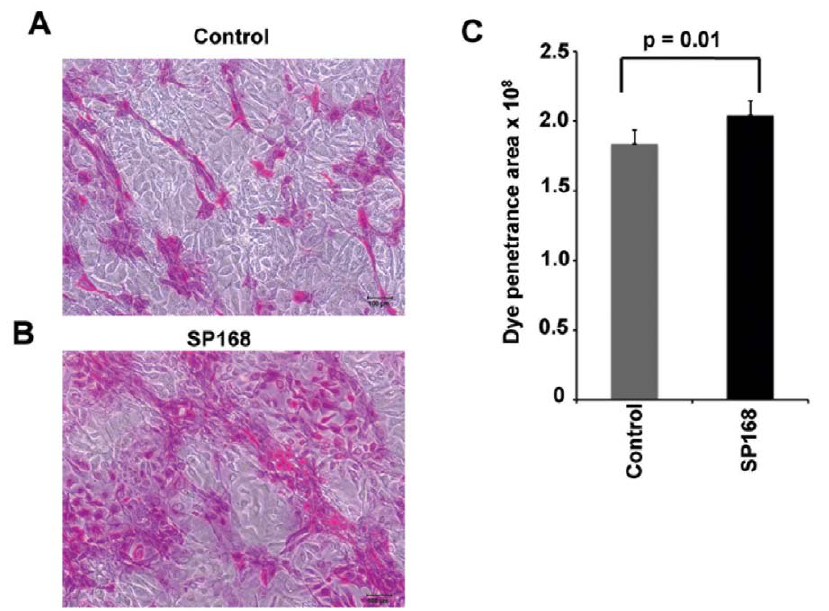
Figure 7. Rose bengal penetrance into HCLE cells increases after SP168 growth culture filtrate treatment. Brightfield micrographs were taken of HCLE cells stained with rose bengal dye following exposure to ( A ) medium only control or ( B ) ZmpC-containing growth culture filtrate obtained from strain SP168. Areas of cells with dye penetrance (p=0.01, Mann-Whitney test, n=55) were quantified using ImageJ software ( C ). Scale bar=100 m m. These data indicate that the barrier efficiency of epithelial cells after exposure to ZmpC decreases due to loss of MUC16 ectodomain. Increased dye penetrance has been shown previously with siRNA knockdown of MUC16 [3].